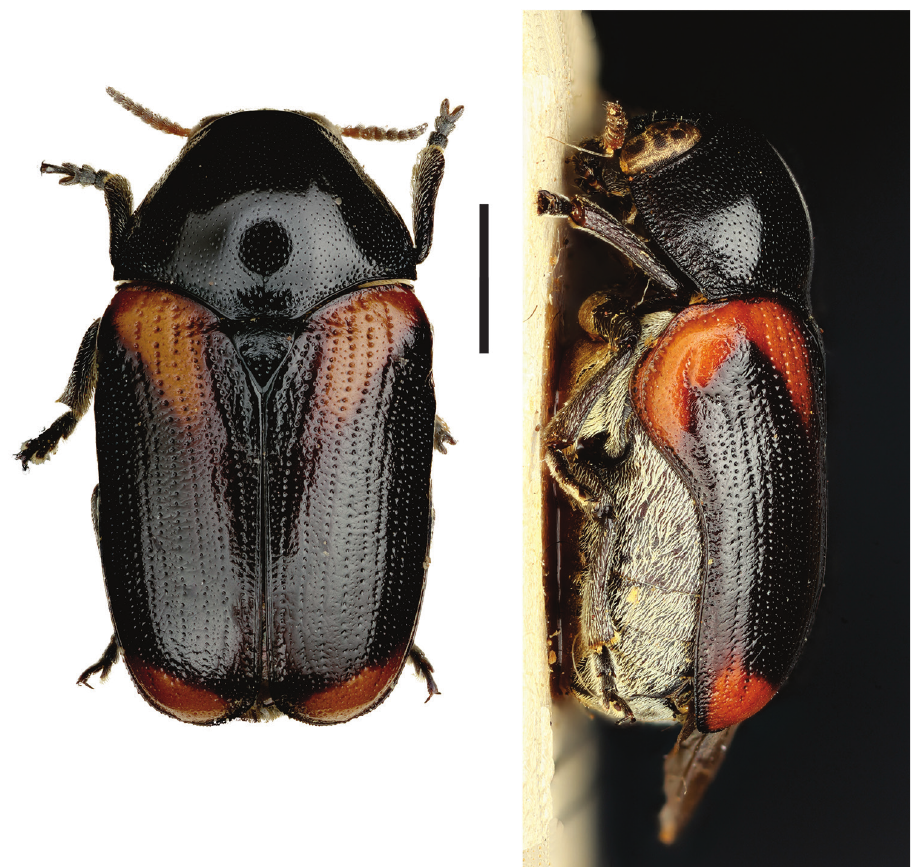
Figure 13. Saxinis ( Saxinis ) meridionalis Monrós (2) , left: habitus (dorsal view), right: habitus (lateral view). Temnodachrys ( Eudachrys ) Monrós, 1953 Type species. Temnodachrys cruciata (Lacordaire, 1848), designated by Monrós (1953b: